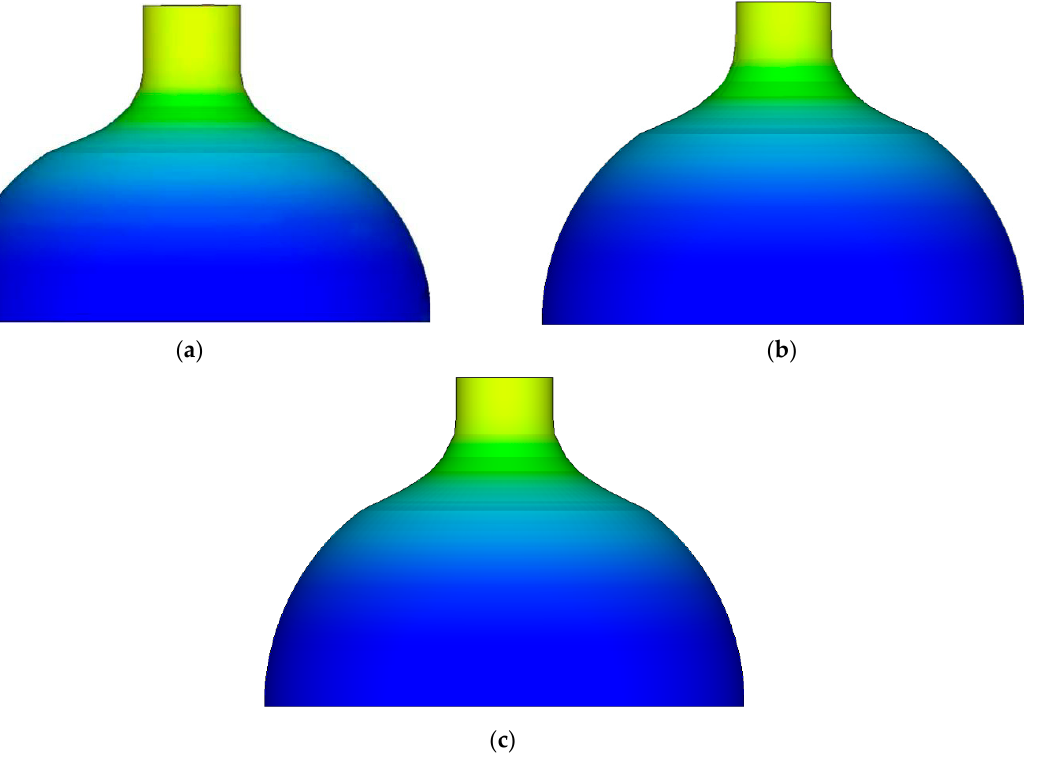
Figure 6. The Cloud diagram of equivalent strain distribution with different feed ratios. ( a ) Feed ratio is 1.5 mm/r. ( b ) Feed ratio is 2.0 mm/r. ( c ) Feed ratio is 2.0 mm/r.